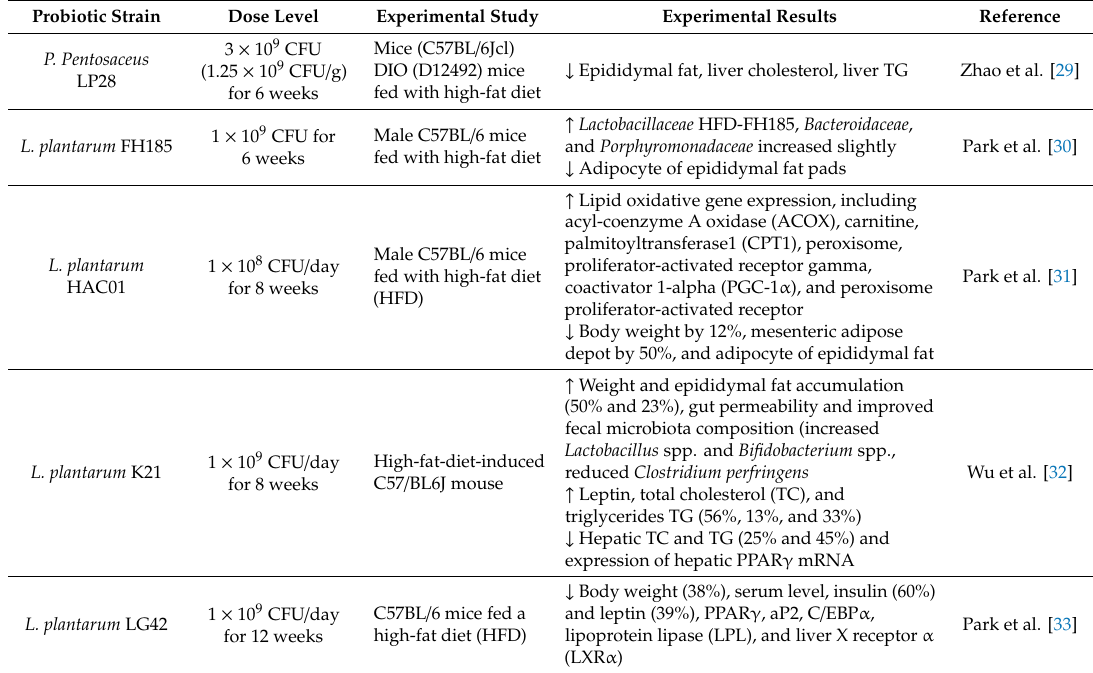
Table 1. Probiotic strains with e ffi cacy against obesity in in vivo animal models. Reprinted with permission from Mishra et al. [28]. Copyright year publisher.